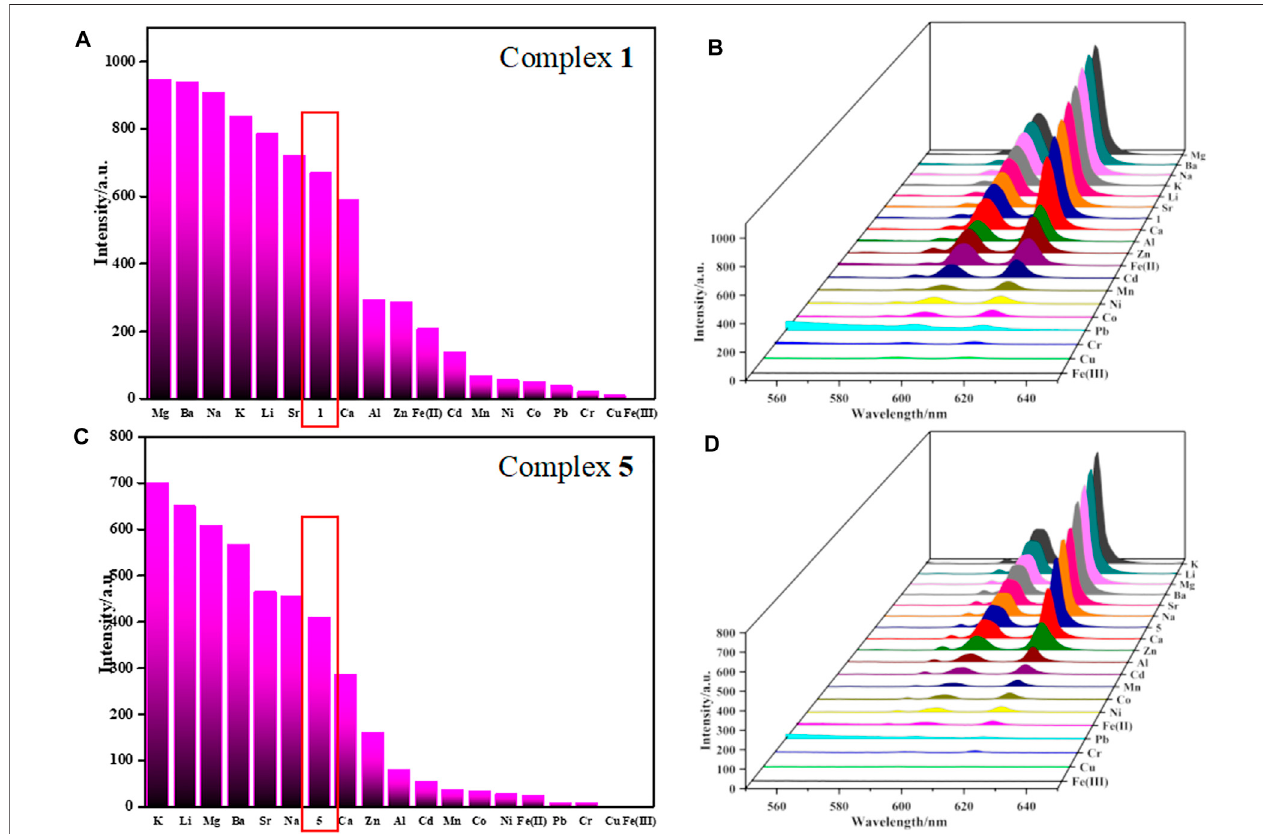
FIGURE3|(A,C) arebargraphofFLresponseof 1 and 5 towardsdifferentmetalions( λ max =616 nm),respectively. (B,D) are3Dplaneofluminescentintensitiesof 1 and 5 in aqueous solution with various metal ions, respectively.